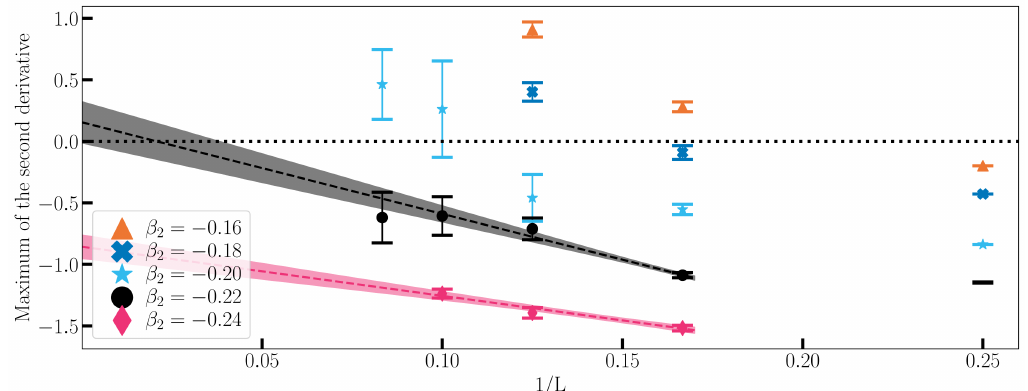
Figure 12 . Dependence of the maximum of the second derivative of the entropy as a function of 1 , for different β 2 (colors). The error bars are obtained by generating histograms from independent L simulations. For β 2 = − 0 . 22 and β 2 = − 0 . 24 , we show a fit (dashed line) and the respective uncertainty (shaded region), to show that the decreasing of the second derivative with β 2 , may result in a second order phase transition. We want to emphasize that the extrapolations are more qualitative than quantitative and that larger lattices are required to perform a controlled infinite volume